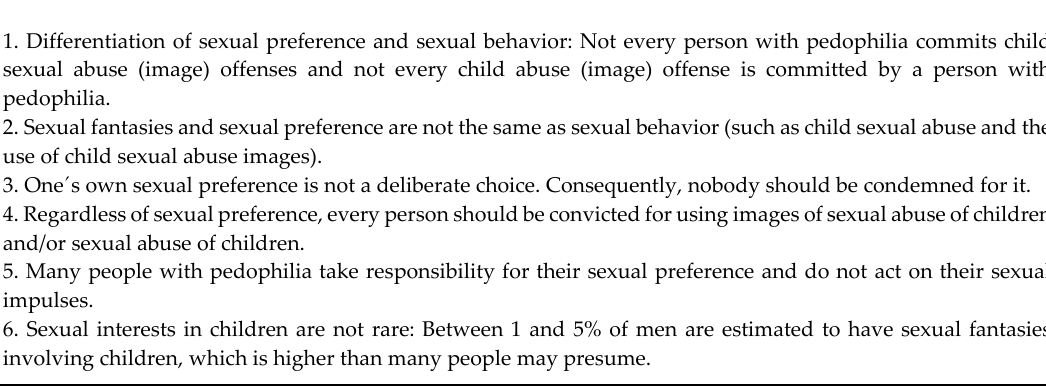
Figure 1. Newsworthy Facts on Pedophilia.